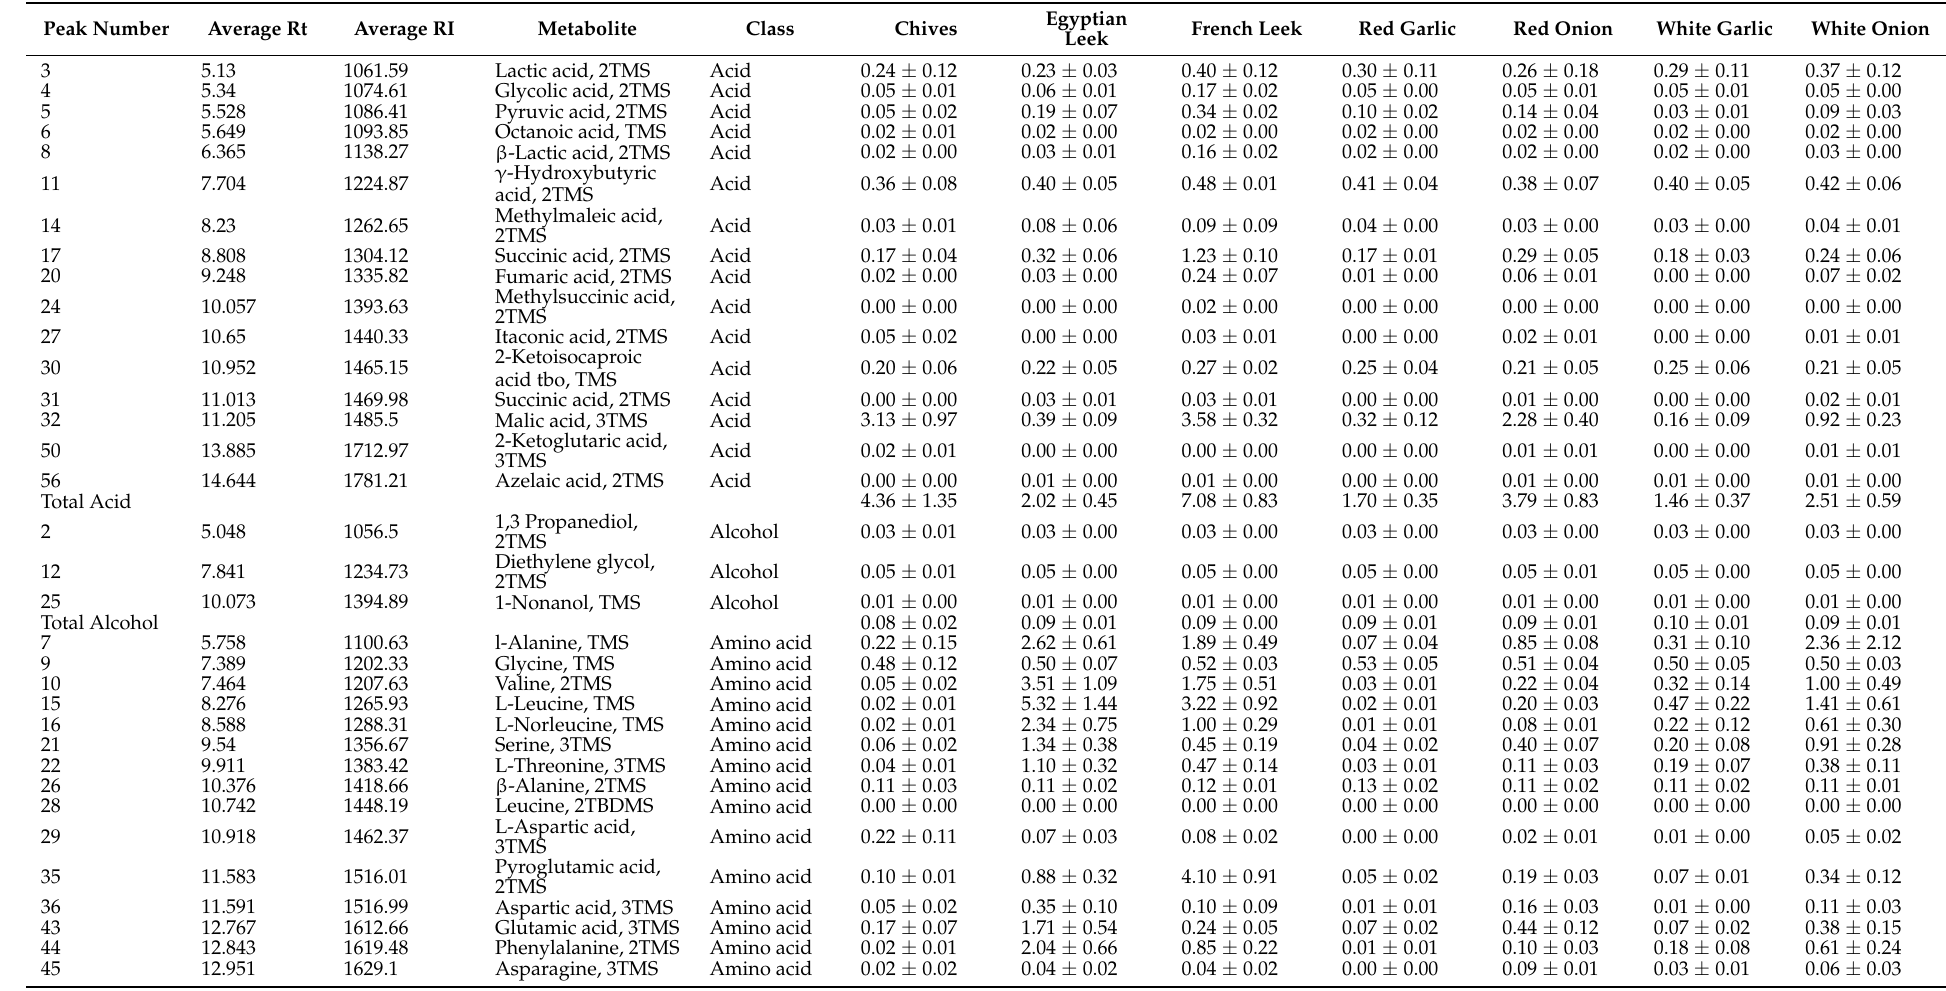
Table 1. Quantification of silylated metabolites in Allium species aerial part (mg/g) analyzed using GC–MS, n =